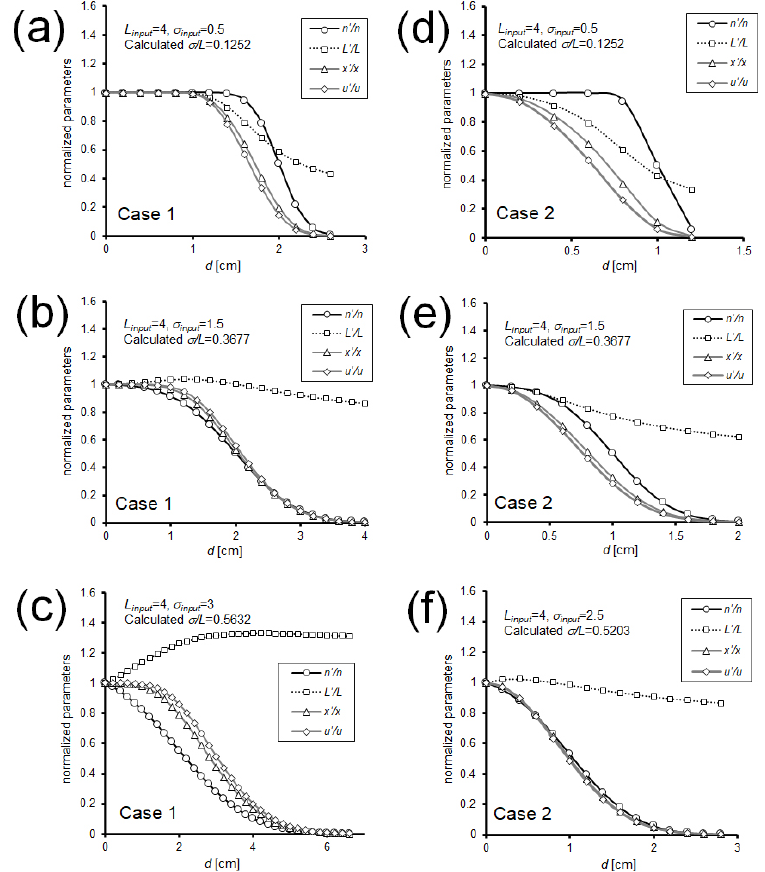
Figure 9. Relations among normalized variables and d in ( a – c ) Case 1 and ( d – f ) Case 2. Each plot represents the output of parameters calculated using given L input , σ input , and d as shown in the flowchart in Figure 6.